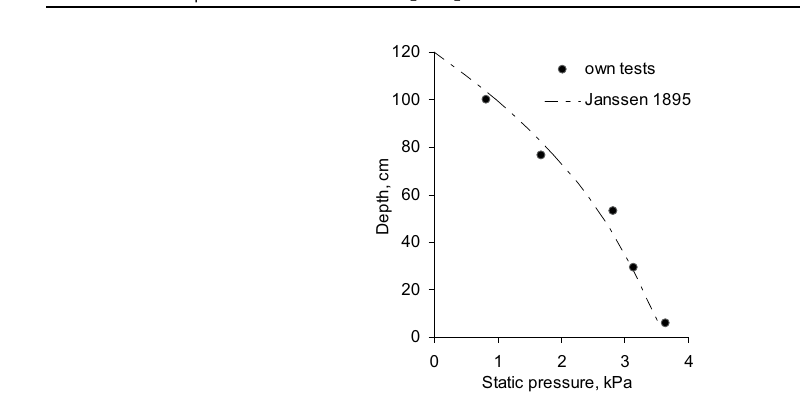
Fig. 4. Setting up of experimental results of static pressures.